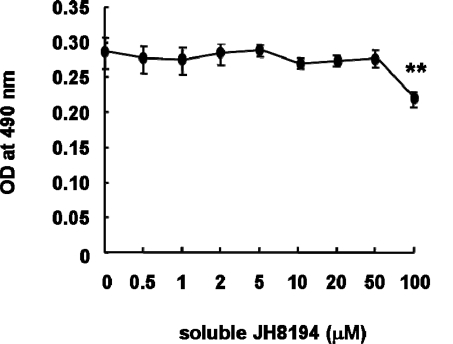
The effects of soluble JH8194 on the proliferation of MC3T3-E1 cells were investigated by MTS assay. The cells were cultured in the presence or absence of soluble JH8194 for four days. Soluble JH8194 was added to each well just once until the following assay. The MTS assay was done to examine the effects of soluble JH8194 on MC3T3-E1 proliferation. Independent experiments were repeated three times. Data represent the means +/– S.D of quadruplicate experiments.